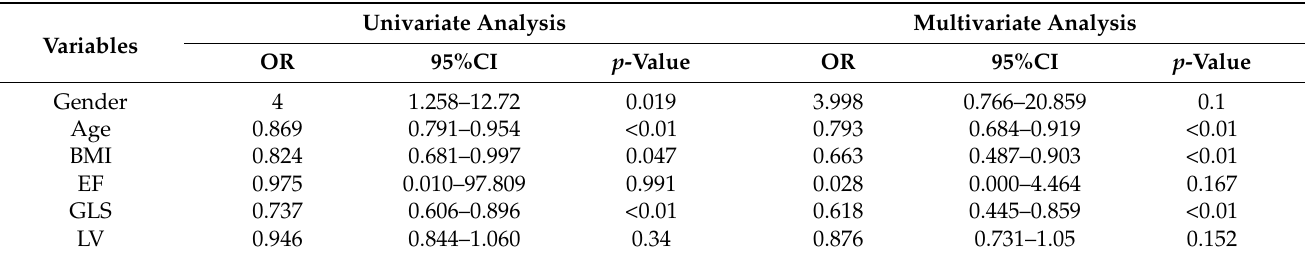
Table 4. Univariate and multivariate predictors to predict reduced exercise capacity (peak VO 2 ) in patients with IHD.